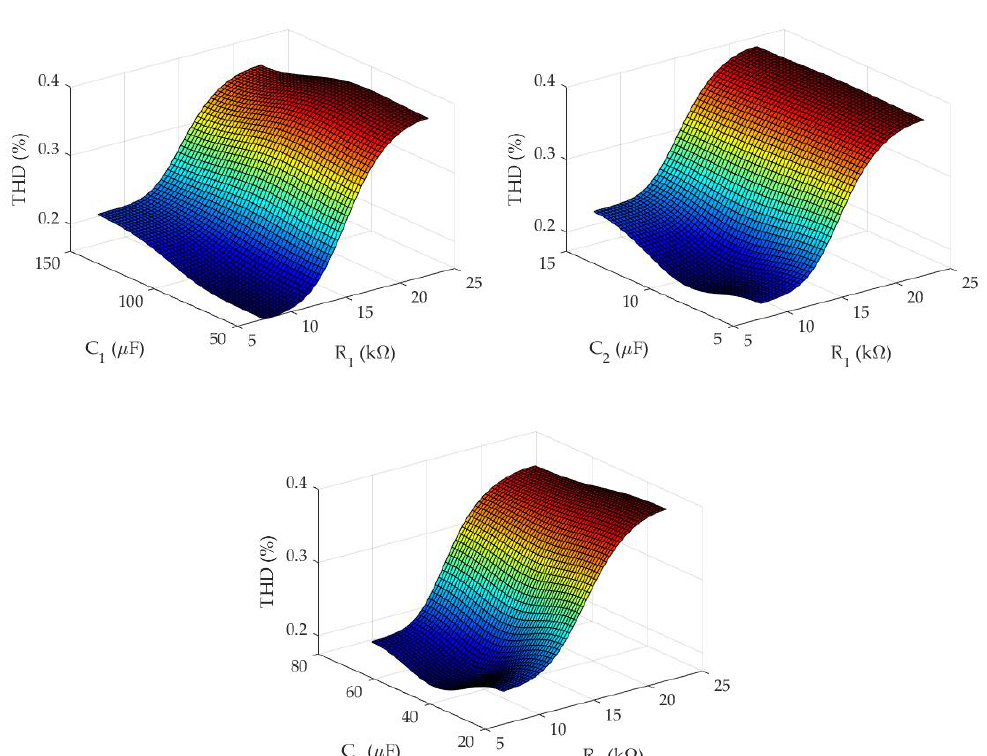
Figure 16. Response surface for THD vs. R 1 and {R 2 , R 3 , R 4 , R 5 , C 1 , C 2 , C 3 }.